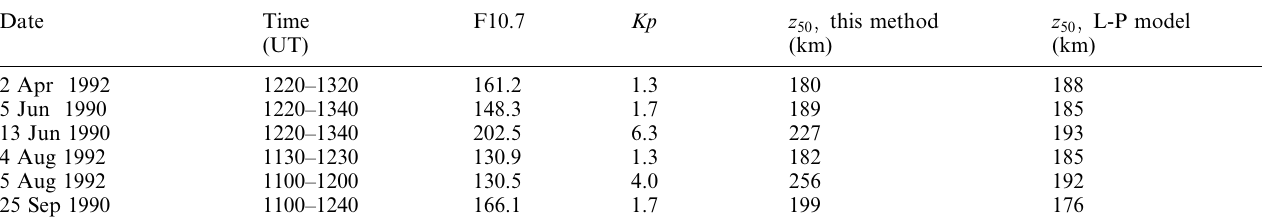
Table 5. Heights, z 50 of the transition ([O + ]/ N e = 0.5) calculated by our method in comparison with the statistical model of Lathuillere and Pibaret